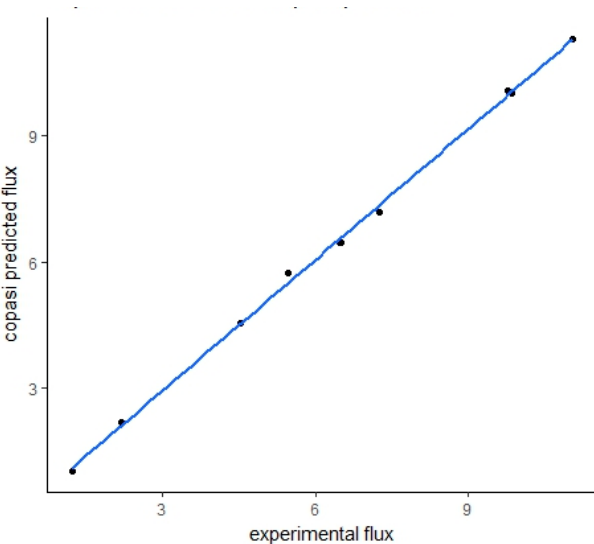
Figure9. CorrelationbetweenFievetetal.[43]experimentalfluxandCopasipredictedflux. Thebalances Figure 9. Correlation between Fievet et al. [43] experimental flux and Copasi predicted flux. The corresponding to these flux values are selected as experimental balances corresponding to these flux values are selected as experimental control.